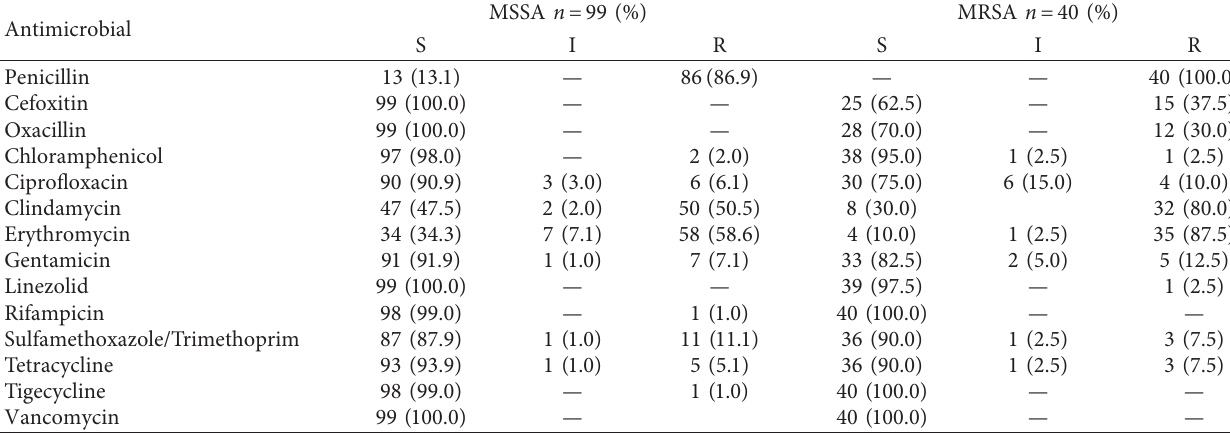
Table 3: Antimicrobial susceptibility of 139 Staphylococcus aureus isolated from nasal swab of healthcare workers and students attending the University Hospital of Londrina in southern Brazil.